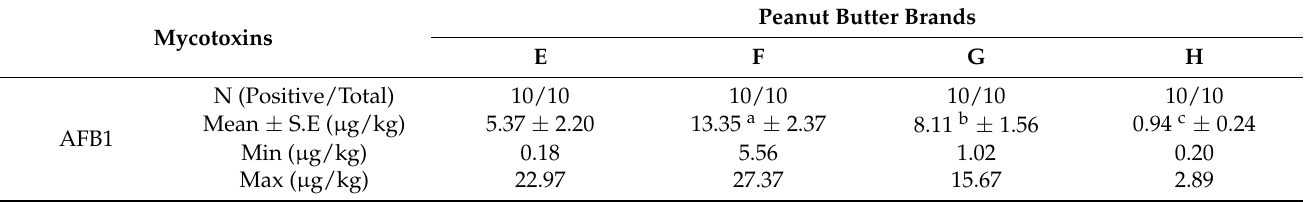
Table 3. Mycotoxin mean ± S.E, as well as the min and max data of positive peanut butter